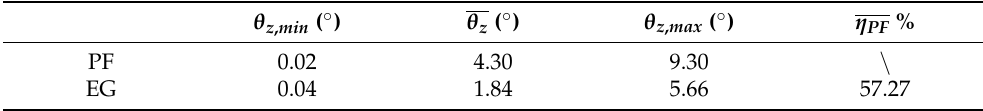
Table 5. Tilt angles θ z in real-world experiments ( ◦